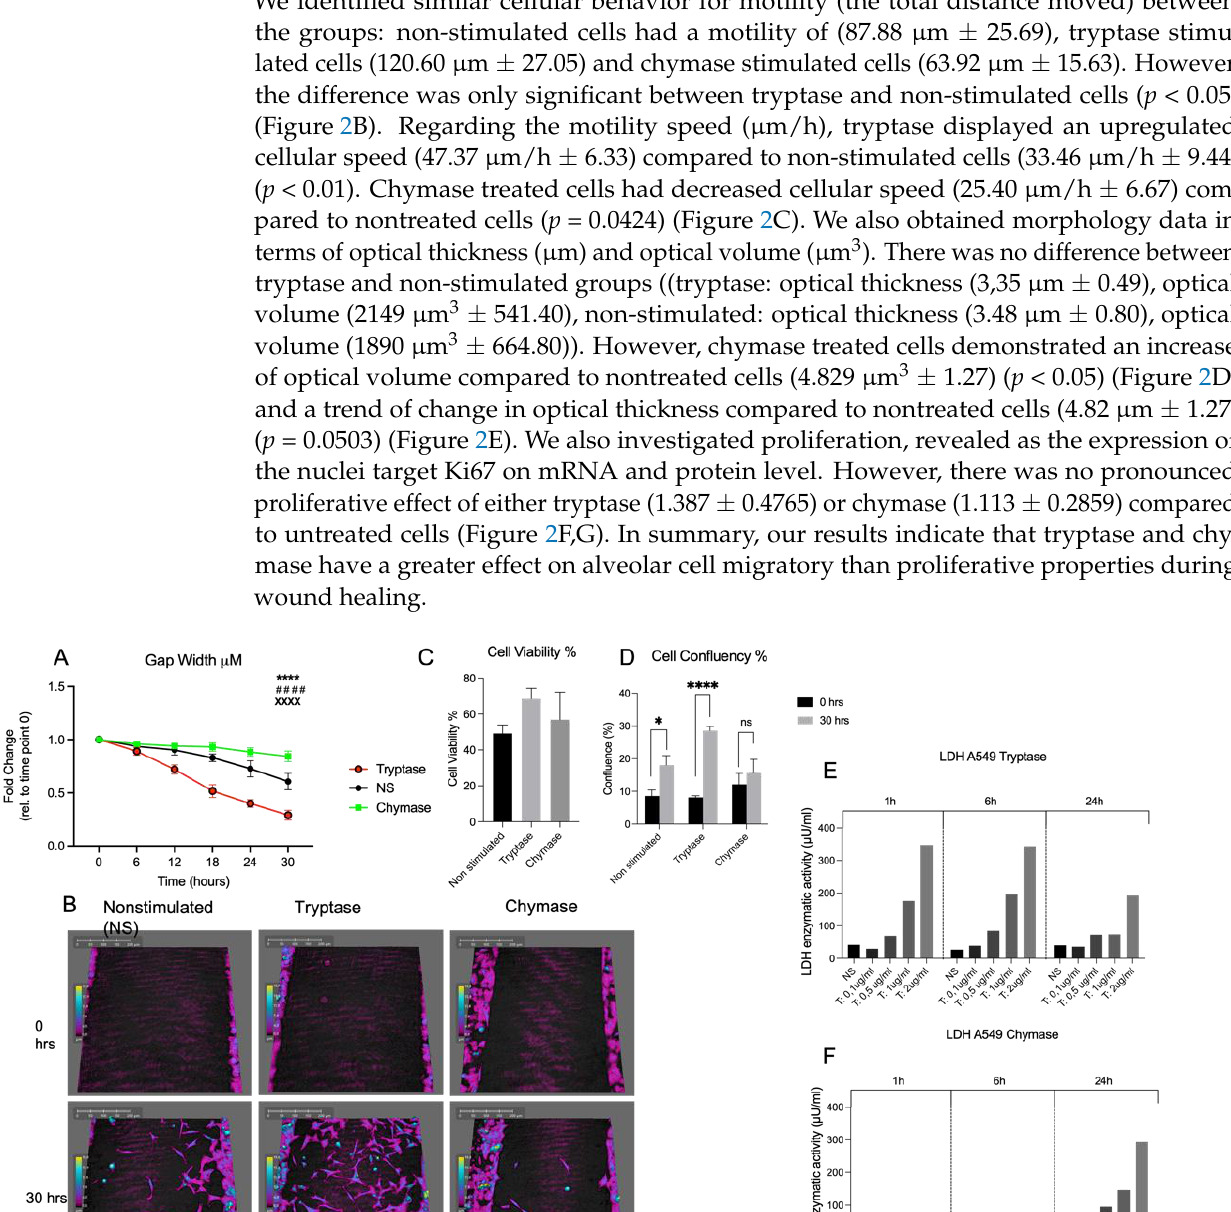
using holographic live cell